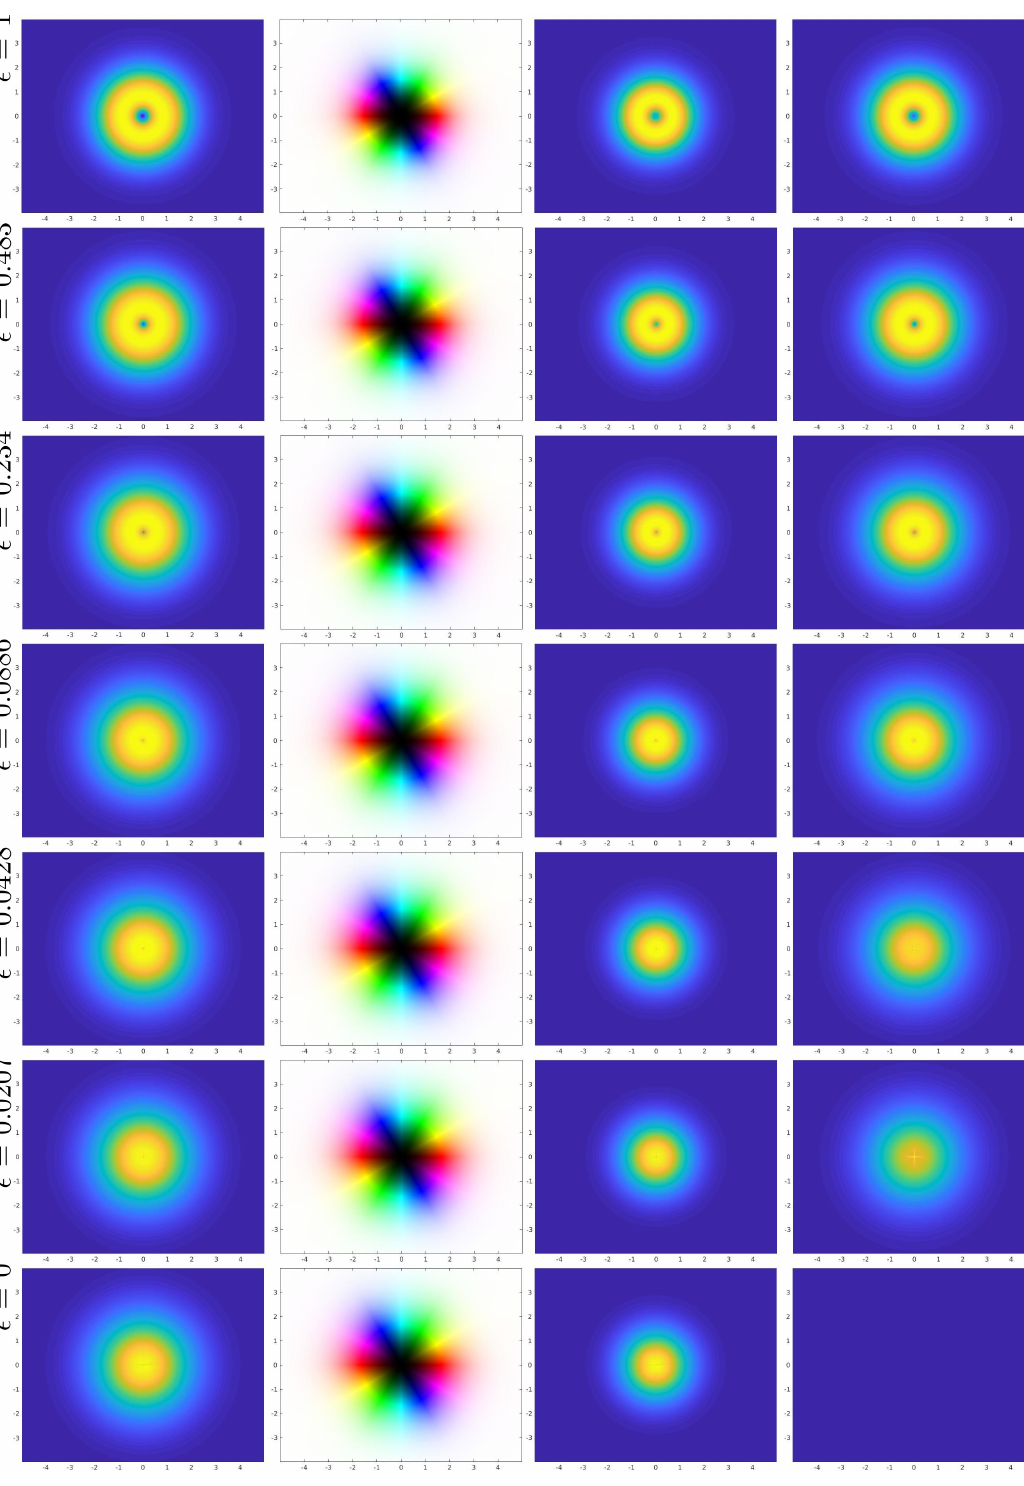
+ m 2 V 1 ) . In this figure m 1 = 0 . 5 2 1